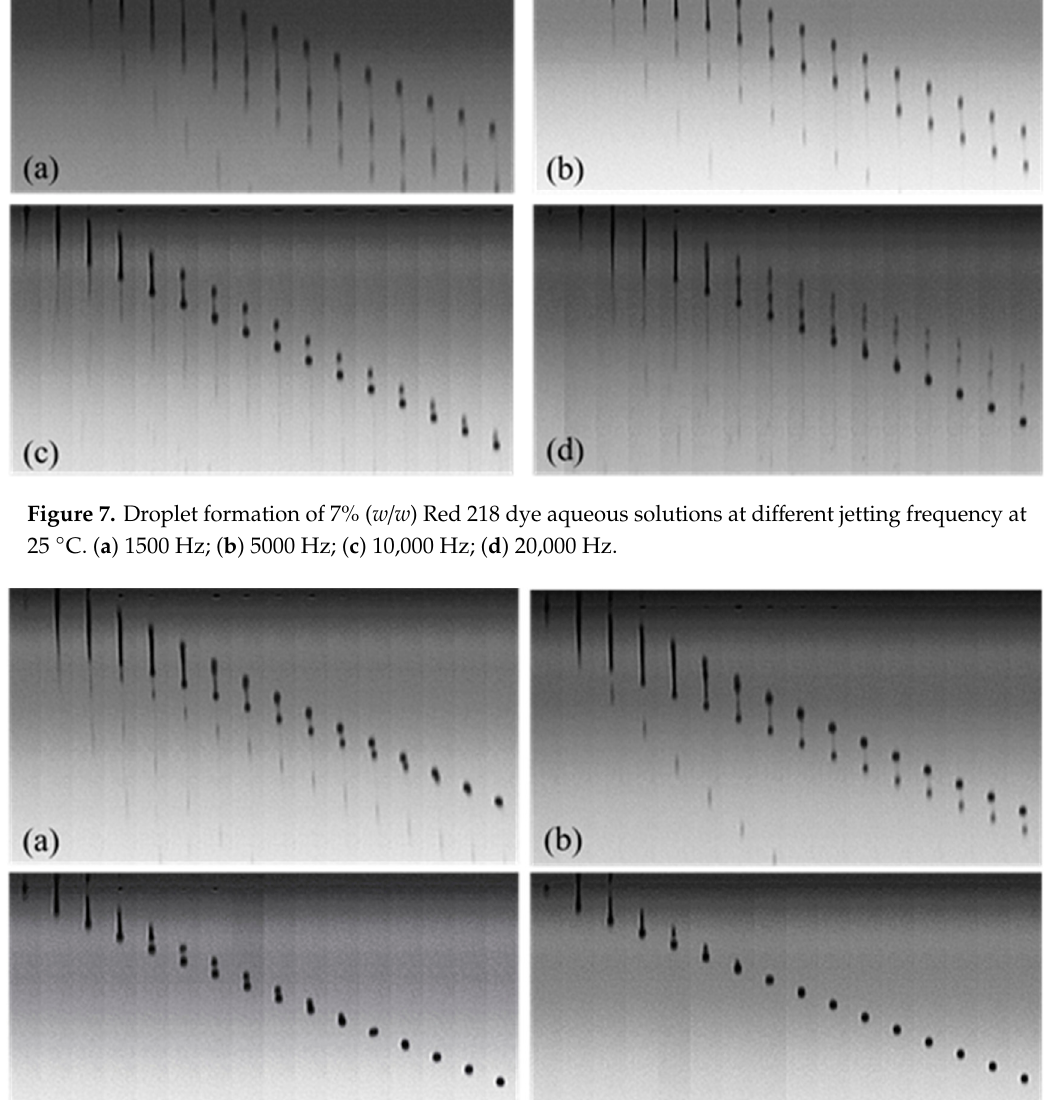
Figure 8. Droplet formation of 7% dye solutions with different concentrations of PEG400 at 25 °C and 10,000 Hz. ( a ) 10% PEG400, ( b ) 20% PEG400, ( c ) 30% PEG400, ( d ) 40% PEG400.